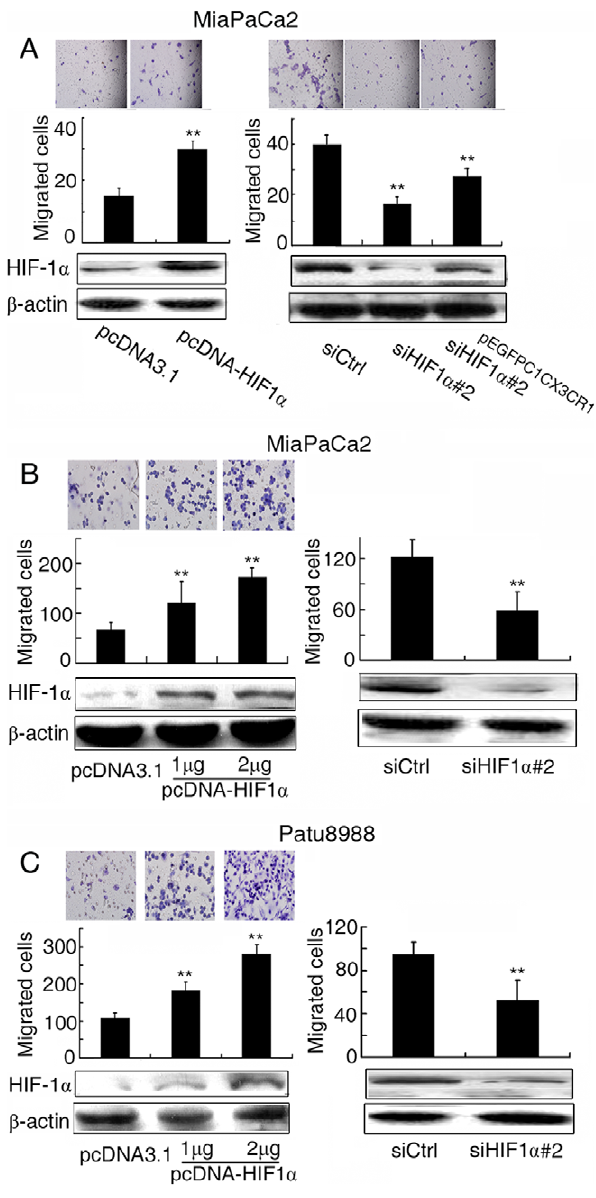
Figure 4. HIF-1 a affected chemotactic migration of PDAC cells through CX3CR1. ( A ) MiaPaCa2 cells were cotransfected with pcDNA3.1-HIF1 a plasmids (1 m g) (left) or with siHIF1 a # 2 (50 nM) and pEGFP-C1-CX3CR1 overexpression plasmids (1 m g) (right) for 48 h and assessed for chemotactic migration (upper) to SK-N-BE conditioned supernatants. Western-blotting (lower) was used to confirm the efficiency of siHIF1 a , pcDNA3.1-HIF1 a and pEGFP-C1-CX3CR1 plasmids. Migrating cells were counted under a light microscope. (magnification: 6 200). ** P , 0.01 versus control. ( B ) Chemotactic migration (upper) of MiaPaCa2 cells transfected with pcDNA3.1-HIF1 a plasmids (1 m g, 2 m g) (left) or siHIF1 a # 2 (50 nM) (right) for 48 h to recombinant CX3CL1. Western-blotting (lower) was used to confirm the efficiency of siHIF1 a and pcDNA3.1-HIF1 a plasmids. Migrating cells were counted under a light microscope. (magnification: 6 200). ** P , 0.01 versus control. ( C ) Chemotactic migration (upper) of Patu8988 cells transfected with pcDNA3.1-HIF1 a plasmids (1 m g, 2 m g) (left) or siHIF1 a # 2 (50 nM) (right) for 48 h to recombinant CX3CL1. Western-blotting (lower) was used to confirm the efficiency of siHIF1 a and pcDNA3.1-HIF1 a plasmids. Migrating cells were counted under a light microscope. (magnification: 6 200). ** P , 0.01 versus